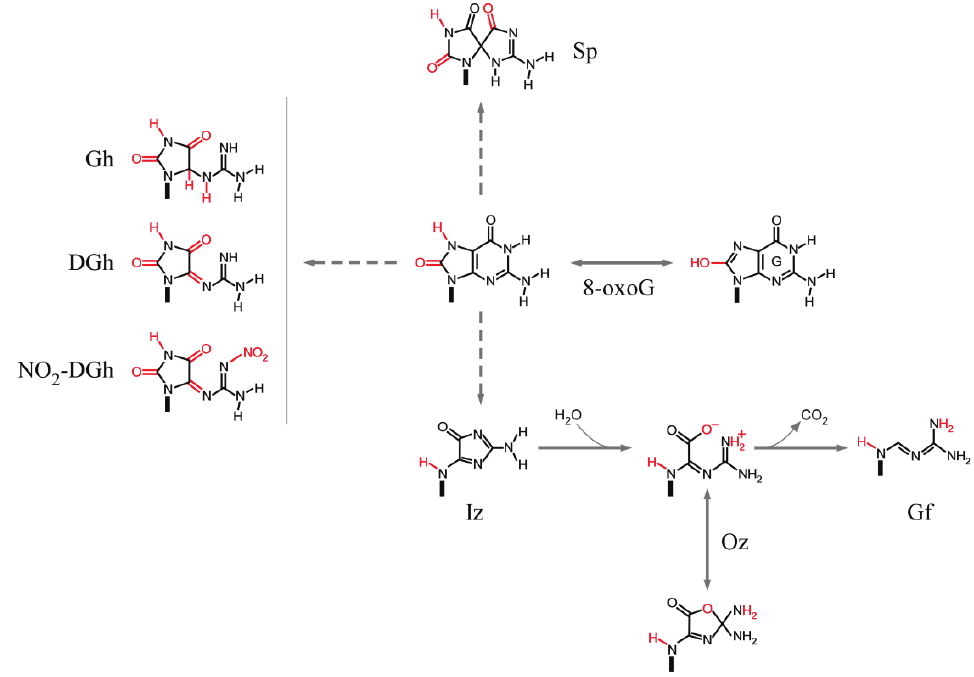
Figure 4. Sequence context-dependent reaction products of